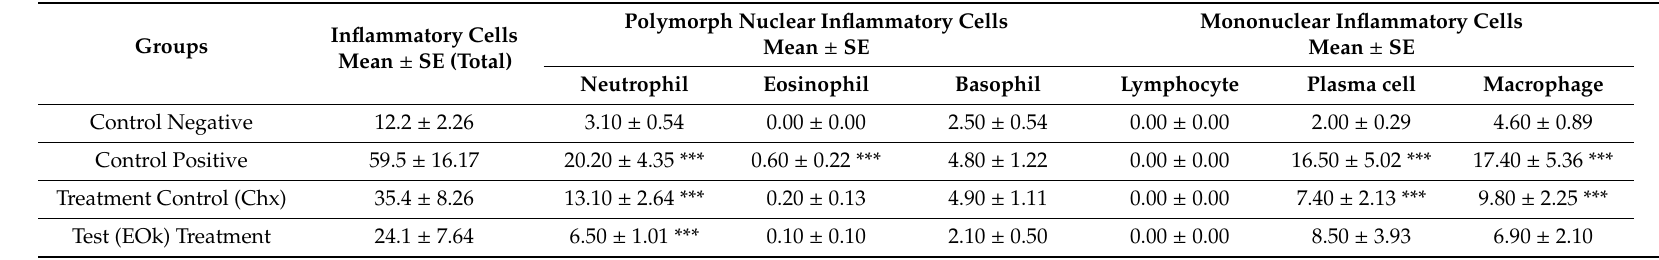
Table 2. The mean ± SE of inflammatory cells in the di ff erent